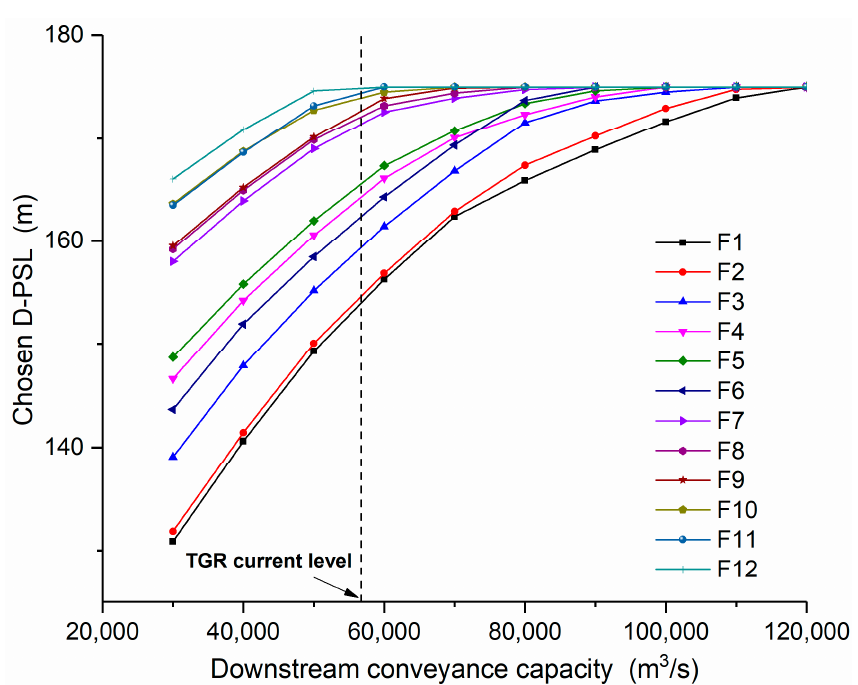
/𝑡 / t s ) (cid:3046) ) s (cid:3294)